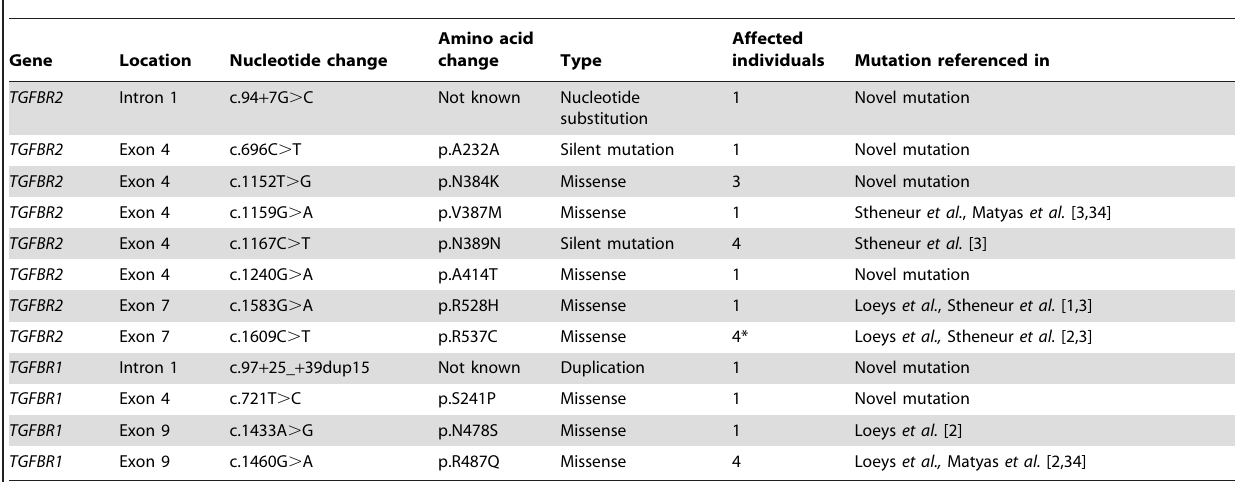
Table 1. Heterozygous TGFBR2 and TGFBR1 mutations identified in LDS patients.